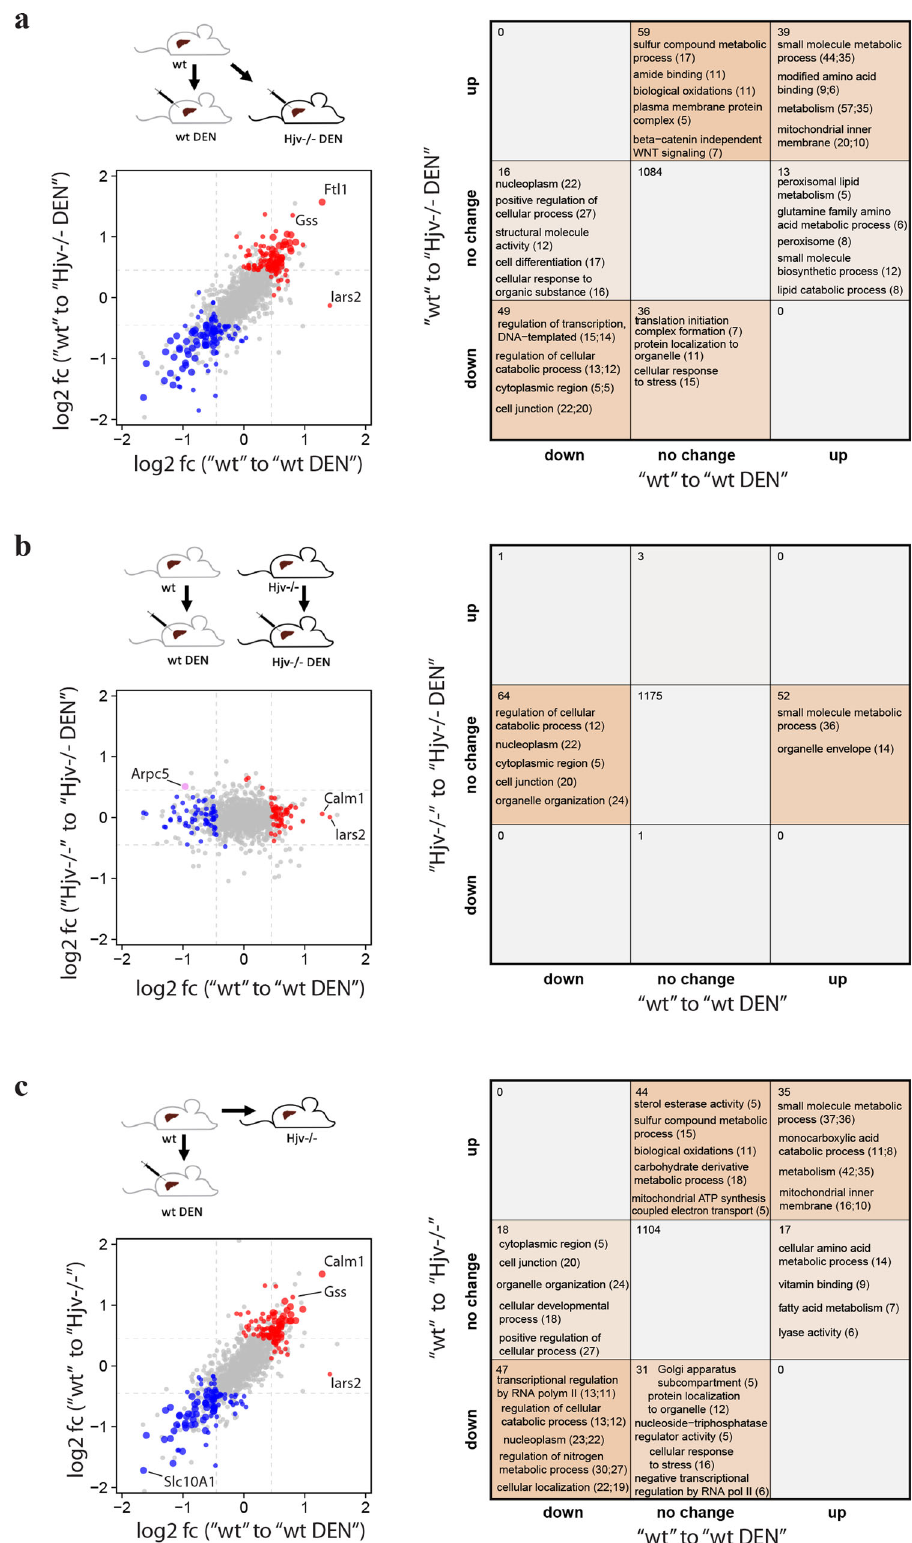
Fig. 3 Comparative analysis of liver proteomes in wild type and Hjv − / − mice following DEN treatment. a Liver proteomic changes between wild type versus DEN-treated wild type and Hjv − / − mice. b Liver proteomic changes in response to DEN treatment in wild type and Hjv − / − mice. c Liver proteomic changes in response to DEN treatment and Hjv de fi ciency. (Left) Log2 fold-changes (log2 fc) of differentially expressed proteins (Tukey p < 0.05, abs. log2 fold change >0.45). Red = upregulated, blue = downregulated, large point = signi fi cant in both. (Right) Number of signi fi cantly changed proteins and enriched annotations (Fisher ’ s exact test p < 0.05) of respective protein